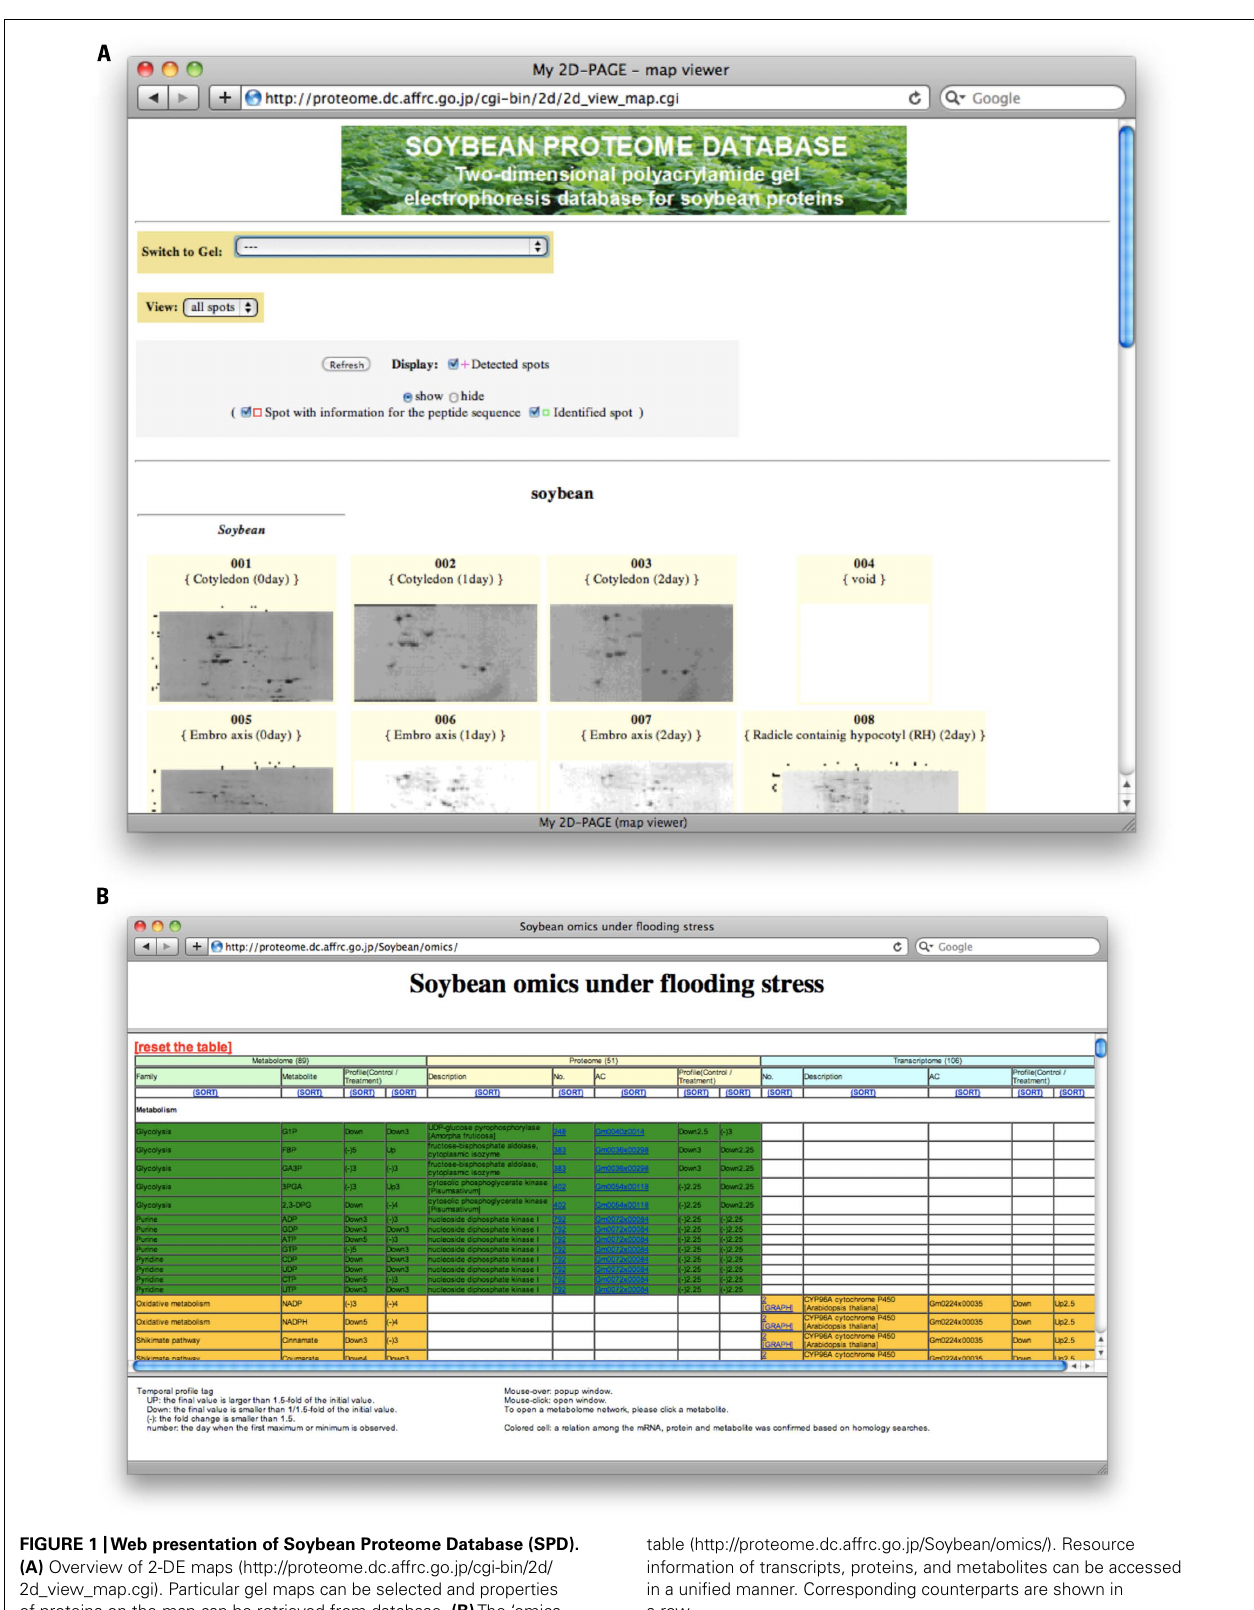
FIGURE 1 |Web presentation of Soybean Proteome Database (SPD). (A) Overview of 2-DE maps (http://proteome.dc.affrc.go.jp/cgi-bin/2d/ 2d_view_map.cgi). Particular gel maps can be selected and properties of proteins on the map can be retrieved from database. (B) The ‘omics